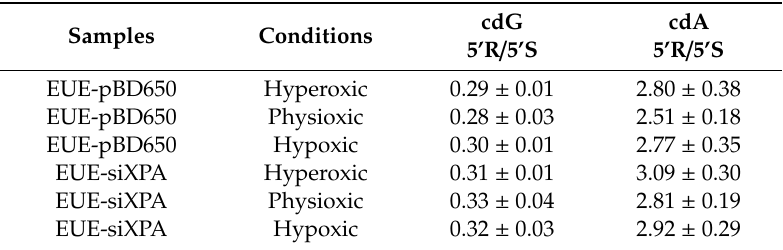
Table 1. 5’ R / 5’ S ratio of cPu lesions in DNA isolated from EUE-pBD and EUE-siXPA cells in hyperoxic, physioxic and hypoxic conditions.